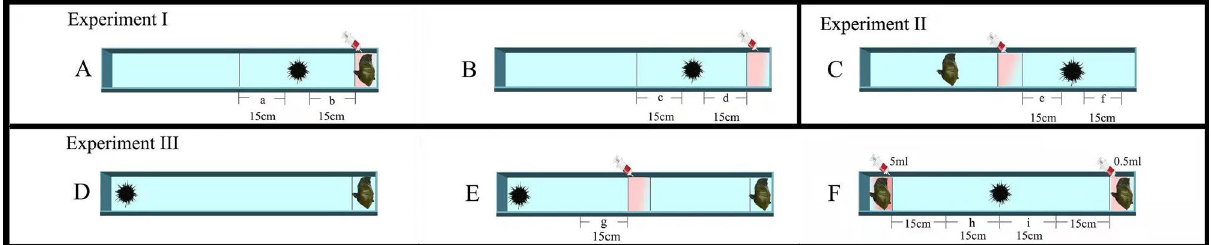
Figure 4. Foraging devices for the experiments with Mesocentrotus nudus . Experiment 1: the kelp was attracted by sea urchins ( A , B ); the positions of a, c and f refer to the escape areas, while positions of b, d and e refer to the danger areas. Experiment 2: five mL of conspecific alarm cues were put in the middle of the device ( C ). Experiment 3 ( D – F ): foraging behavior of M . nudus at 70 cm in the first trial ( D ); five mL of conspecific alarm cues were put in the middle of the device in the second trial ( E ); the position of g refers to the danger area; different amounts of conspecific alarm cues (5 mL and 0.5 mL) were put in the left and right of the devices in the third trial ( F ); the positions of h and i refer to the safety areas close to the areas with more and less conspecific alarm cues, respectively. This figure was created using the Adobe Photoshop (version CS5)